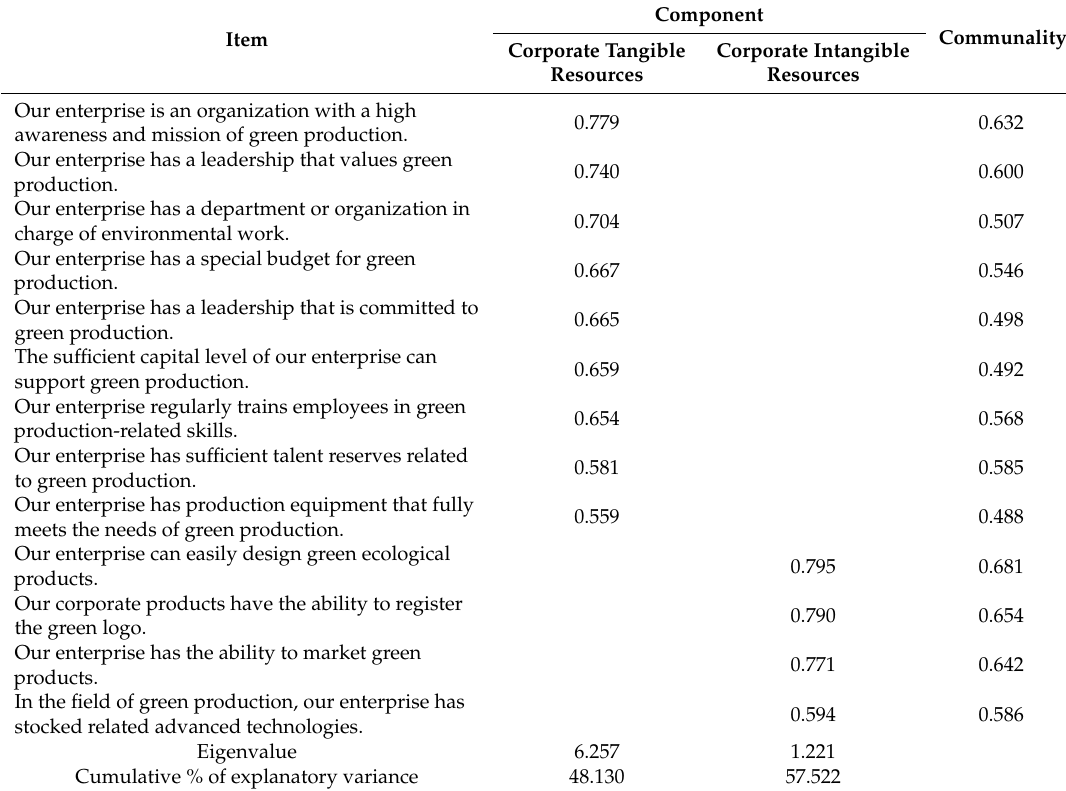
Table 4. Principal component and factor loadings of IFs sub-scale ( N = 853).